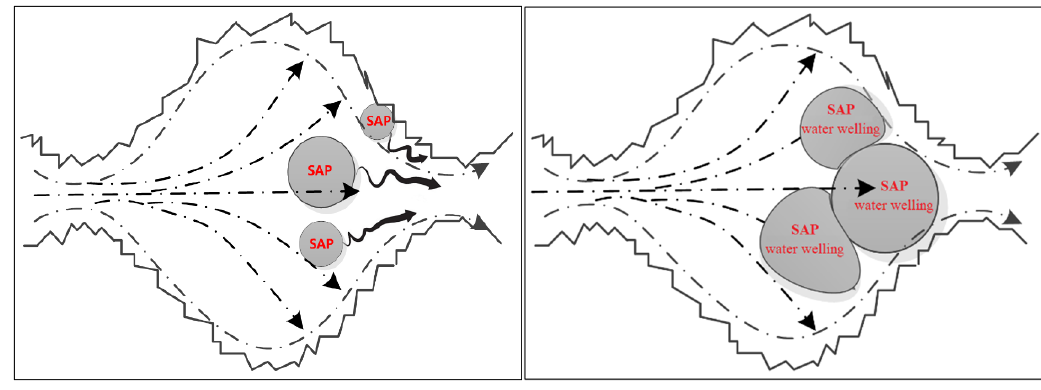
Figure 13. The schematic diagram of the “threshold effect”.